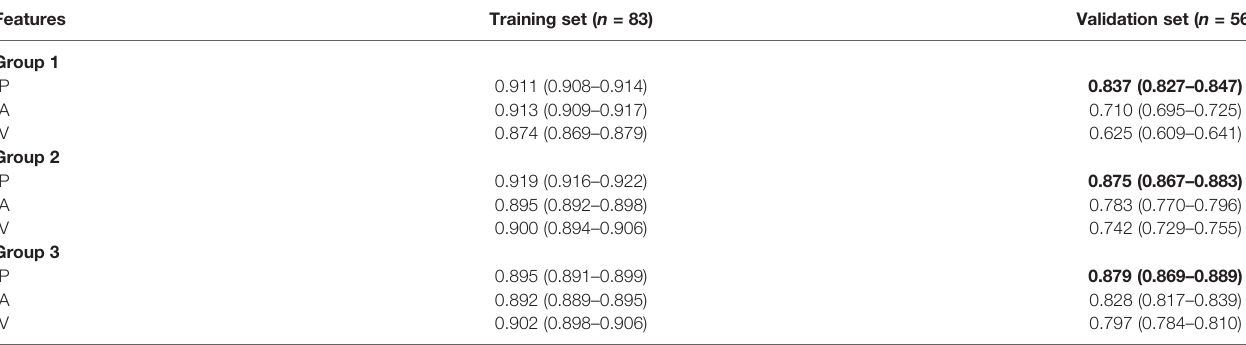
TABLE 3 | Results of training and validation: plain (P), arterial (A), and venous (V); unless otherwise speci fi ed, the contents of parentheses are 95% con fi dence intervals. Features Training set ( n = 83) Validation set ( n =